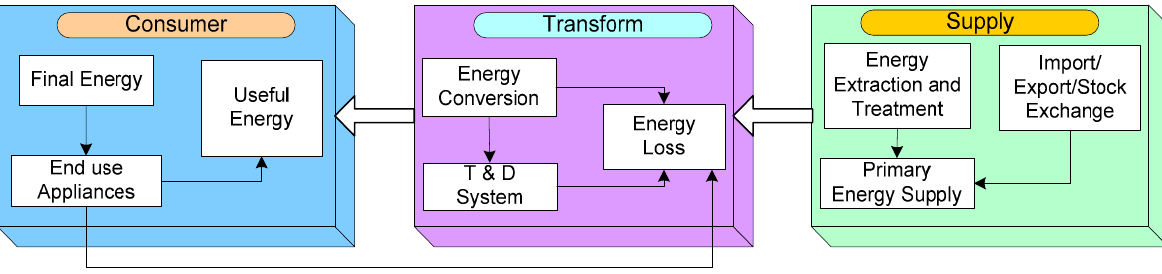
Figure 10. Energy Supply Chain.